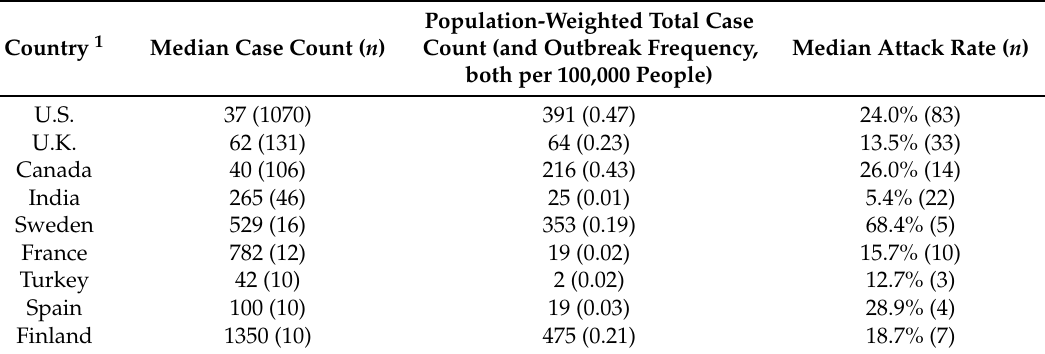
Table 3. Outbreak health data by country (top nine